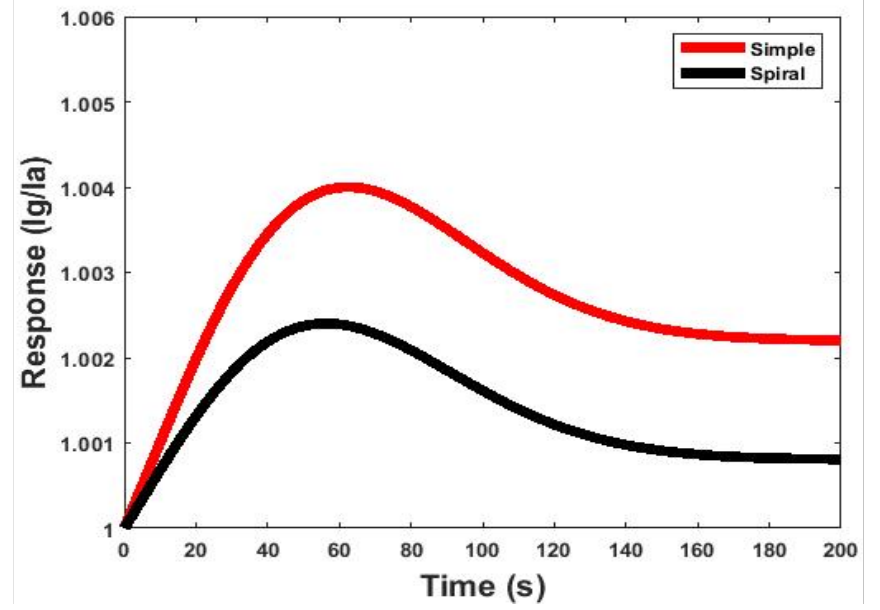
Figure 5. The gas response of the simple and serpentine models of microfluidic-based gas sensors with the same length and height at 2.6 ppm concentrations of acetone gas operated at room